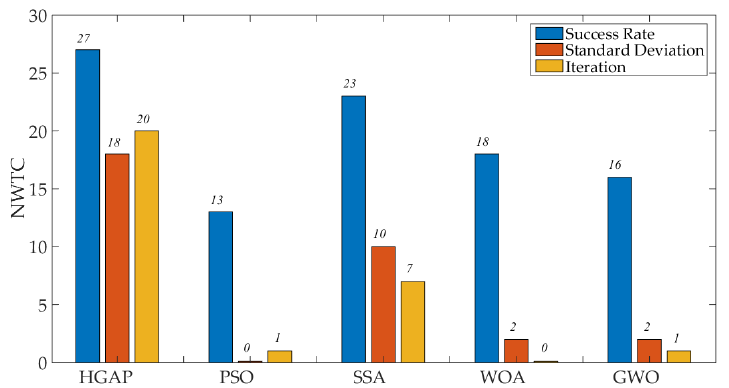
Figure 3. NWTC for each algorithm.